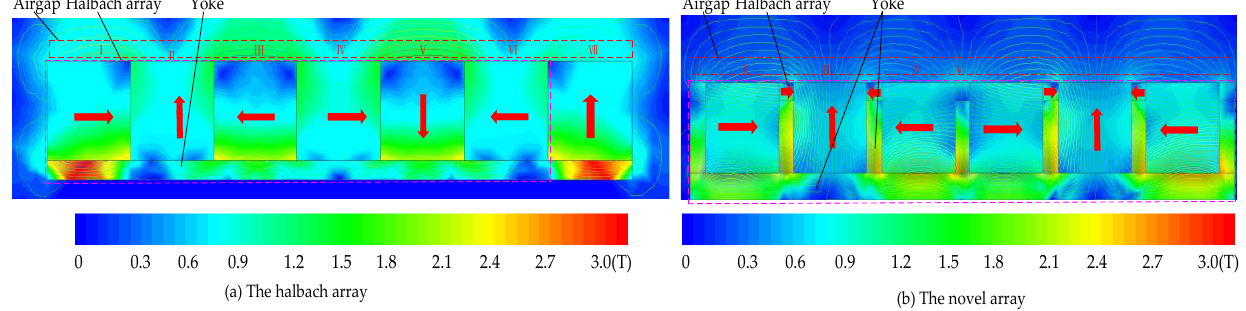
Figure 9. The magnetic density cloud map of the two schemes